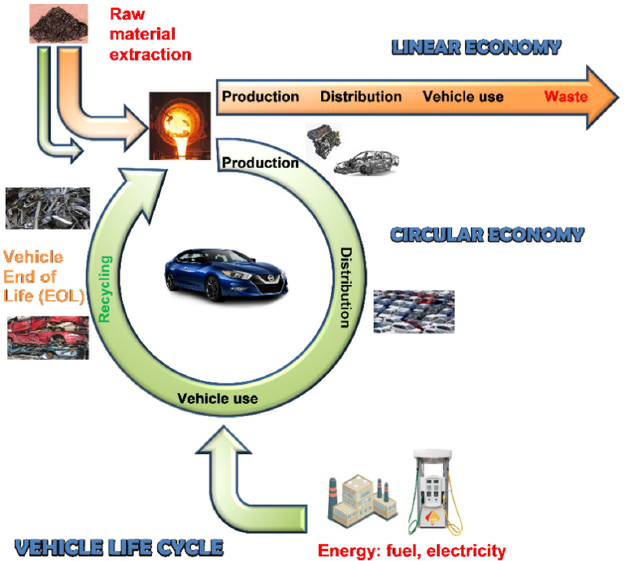
Figure 1. Schematics explaining the vehicle Life Cycle Assessment that encompasses all phases of the product cycle, from raw material extraction to end ‐ of ‐ life recycling and disposal.